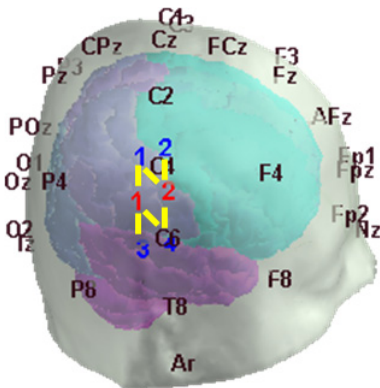
Fig. 1. Optical probe. Symmetrical source detector localiz- ation on both hemispheres. The red and blue numbers indicate the position of sources and detectors, respectively. The yellow lines indicate a source – detector